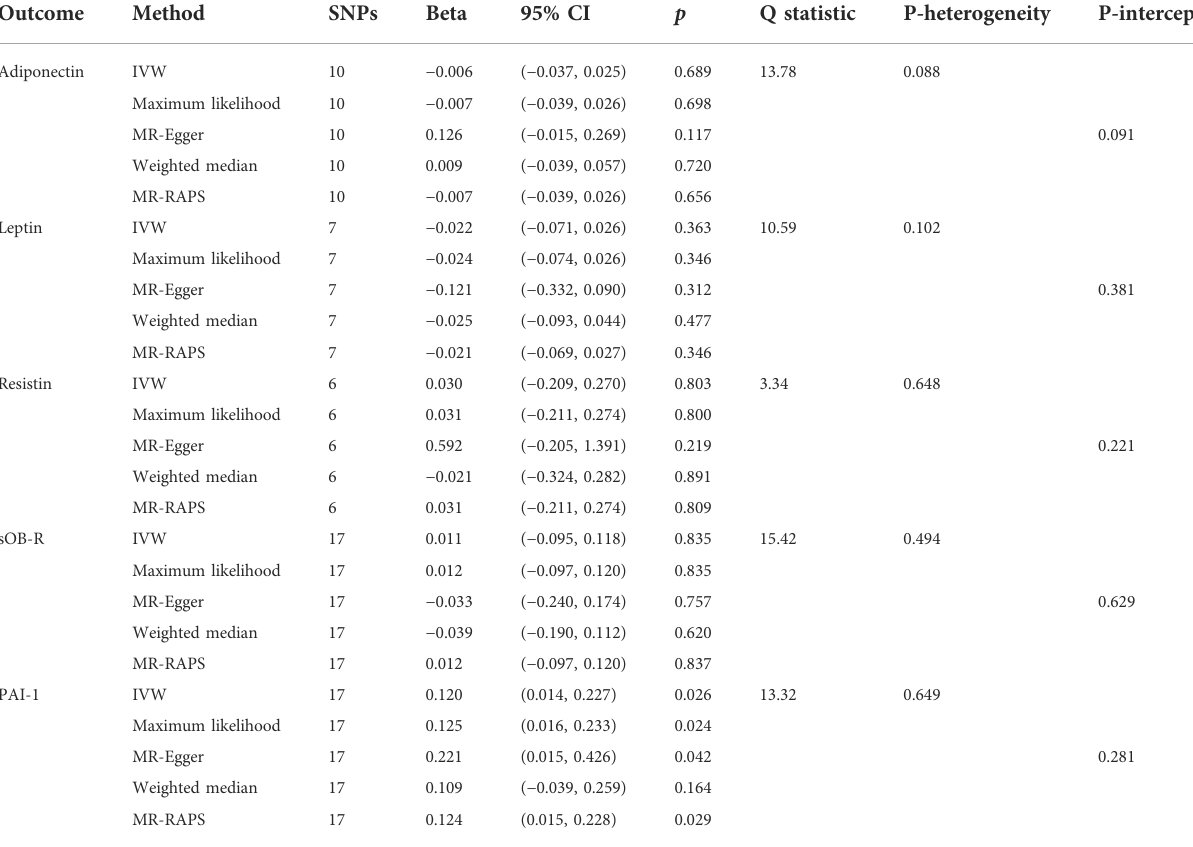
TABLE 3 Two-sample MR estimates of associations between genetically predicted PET and circulating adipokine